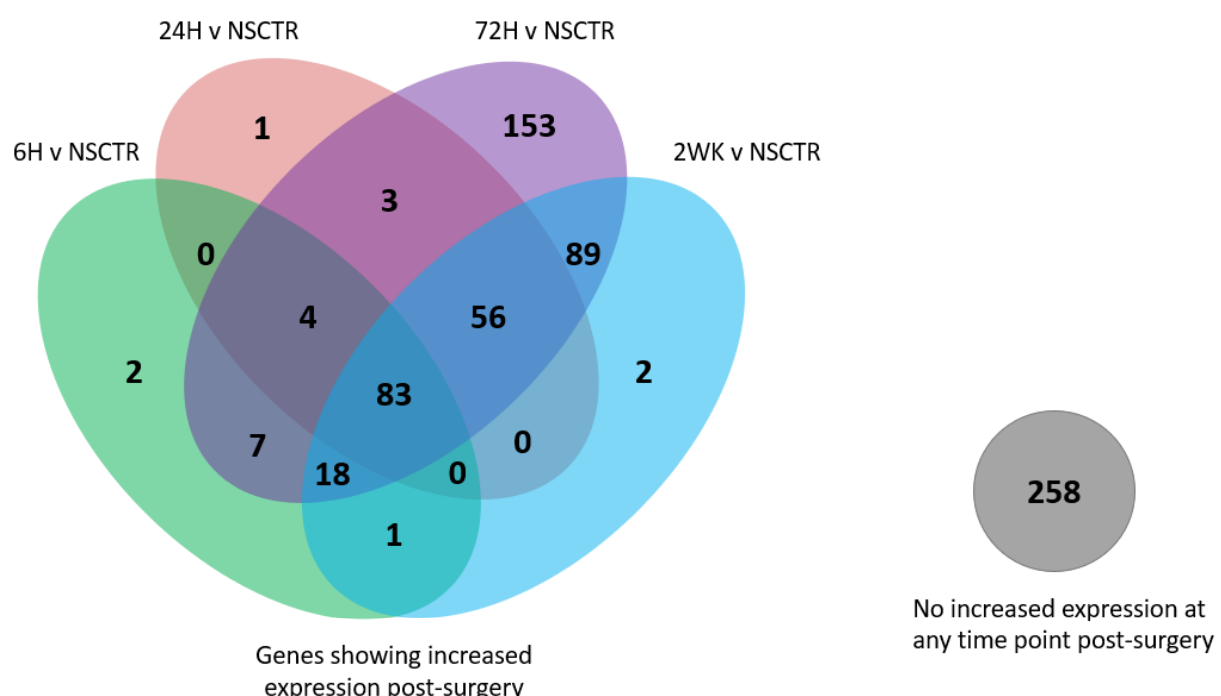
Figure 2. Venn diagram of the number of genes showing altered expression post-surgery compared to Non-Surgical Control (NSCTR). Only genes above the expression threshold of 25 counts in over 85% of the samples are included. (log2foldchange > 1 or < − 1, P adj < 0.05). Overlapping points on the diagram (blended color) indicate the same genes demonstrating altered expression across both time points.